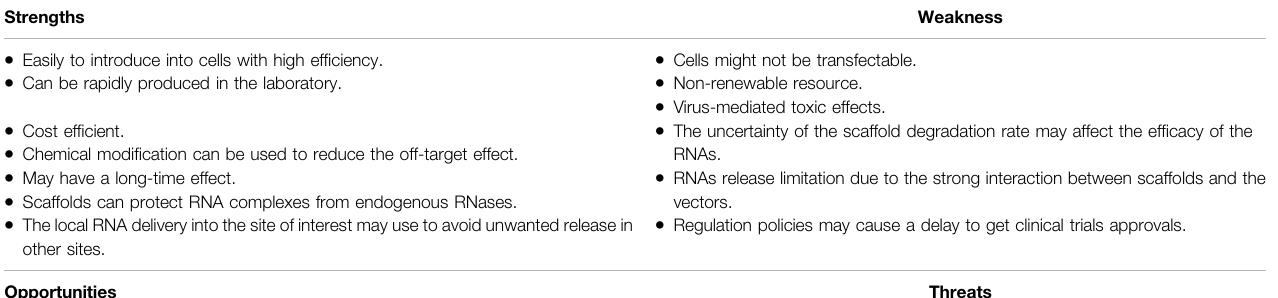
Opportunities Threats